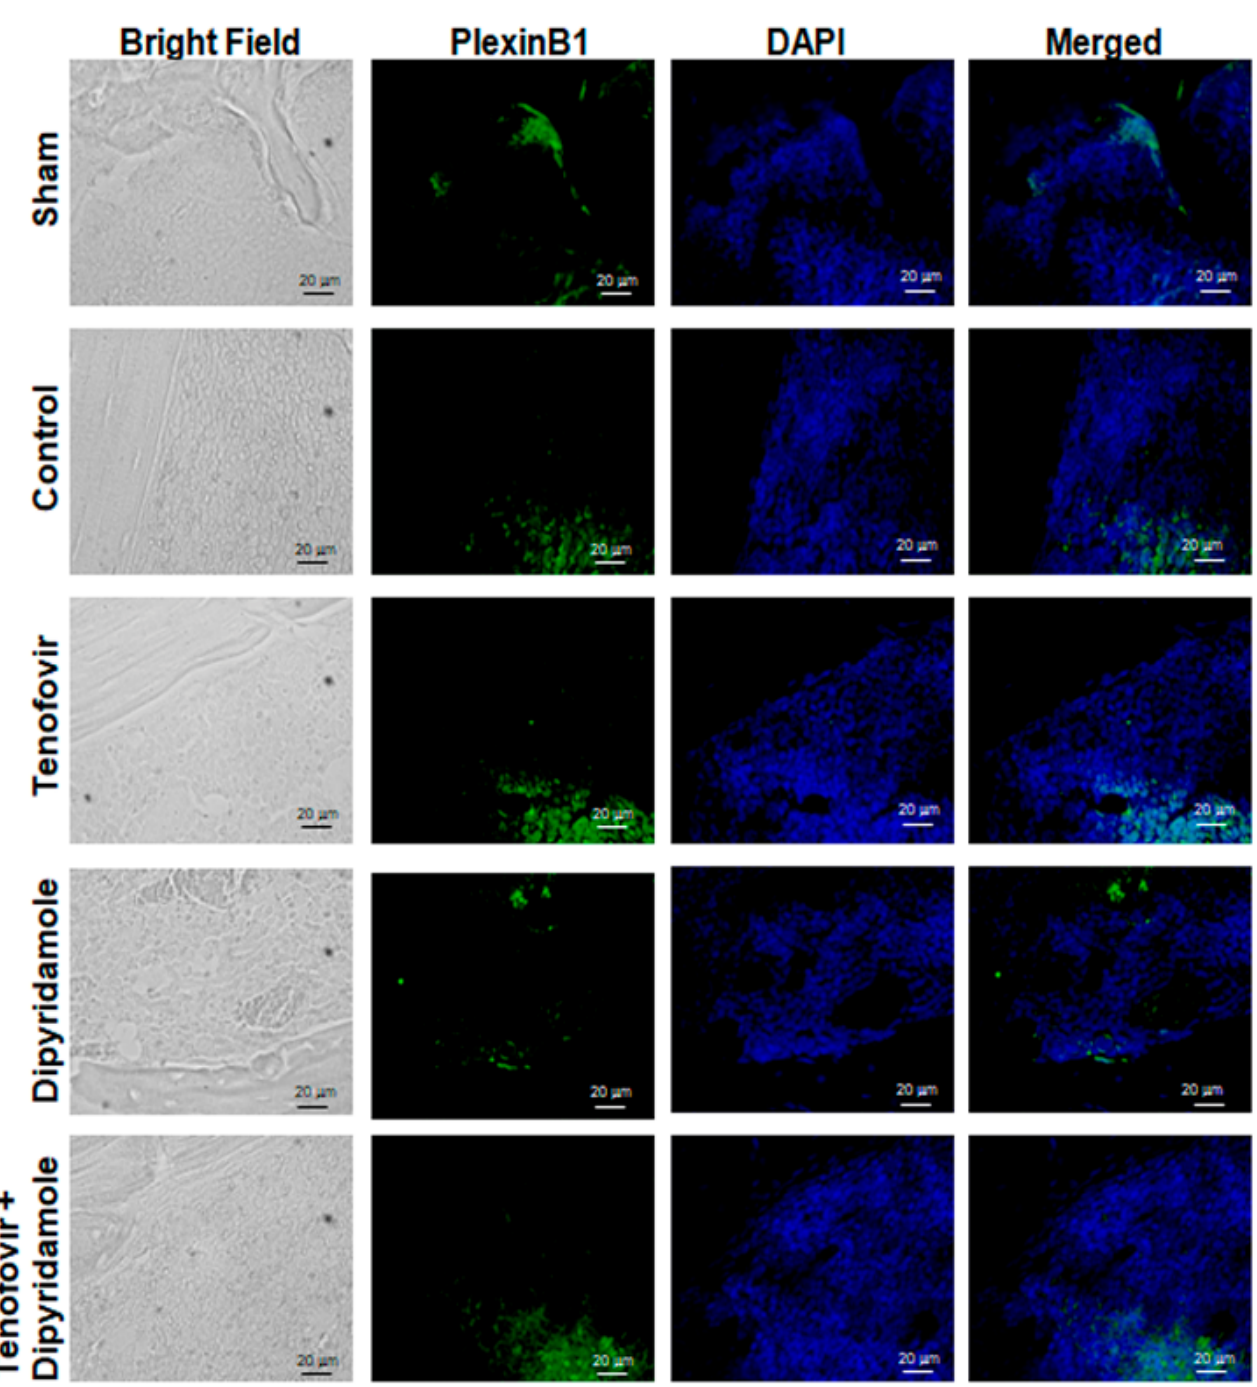
Figure 2. OVX mice treated with tenofovir showed no changes in PlexinB1. Long bones were processed and immunohistologic staining was carried out. Representative images stained for PlexinB1 (green); Nuclei are shown in blue (Dapi). All images were taken at 40× magnification and scale bar indicates 20 μ m segment.